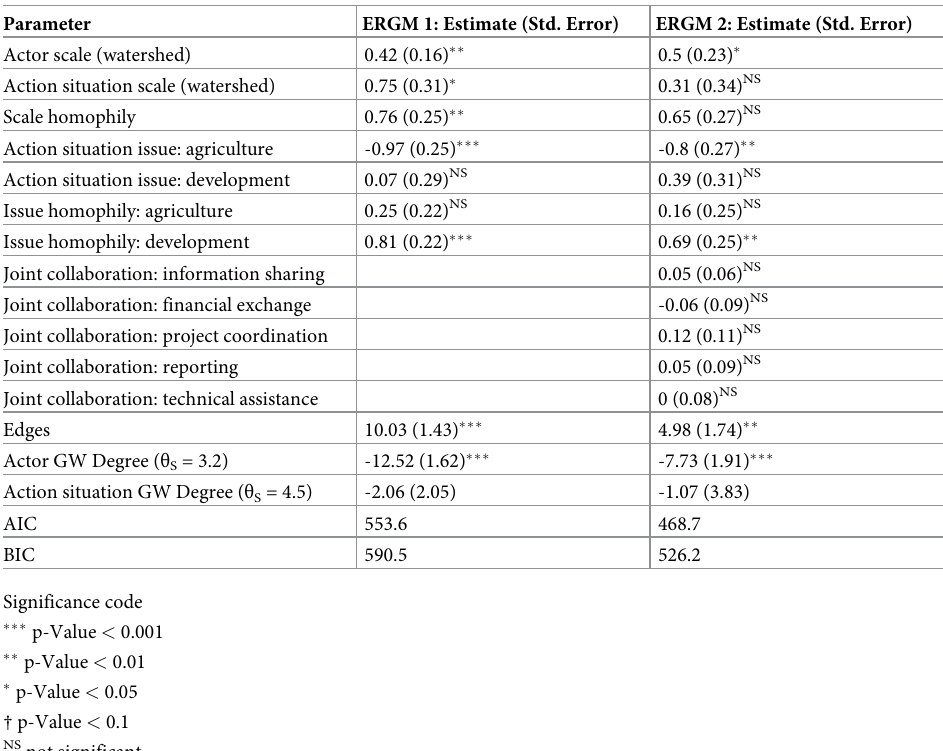
Table 4. ERGM results. Model 1 contains terms related to spatial scale and focal issues of concern. Model 2 includes all terms from model 1 and adds joint collaboration as explanatory variables. Parameter ERGM 1: Estimate (Std.